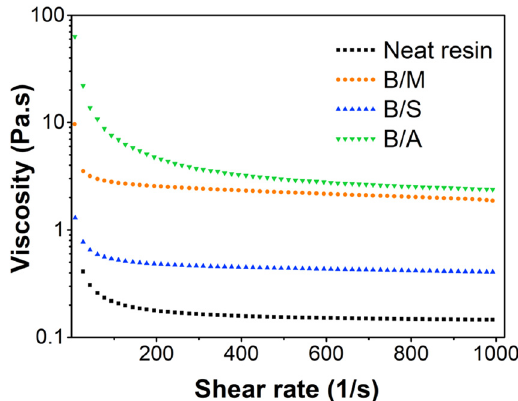
Figure 5: Viscosity versus the shear rate of the neat epoxy resin and epoxy resins containing various core/shell